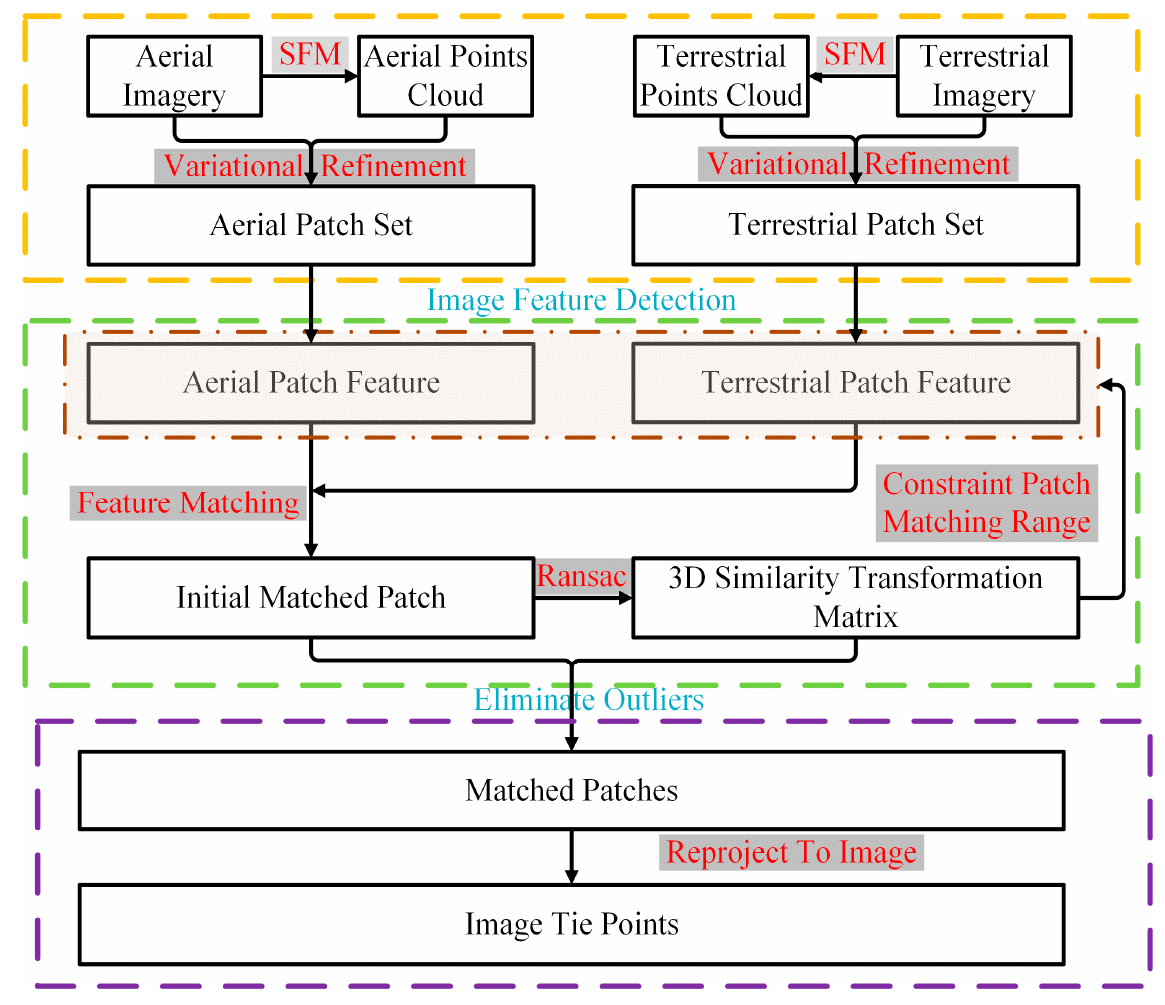
Figure 3. Flowchart of the patch-based matching strategy.